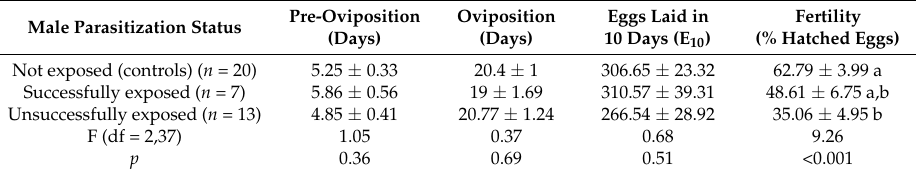
Table 3. Pre-oviposition and oviposition duration in days, total eggs laid in 10 days (E 10 ) and fertility (% hatched eggs) (means ± SE) of H. axyridis females paired with males not exposed to D. coccinellae (controls), exposed and successfully parasitized (successfully exposed) or exposed but not successfully parasitized (unsuccessfully exposed). Pre-Oviposition Oviposition Eggs Laid in Fertility Male Parasitization Status (Days) (Days) 10 Days (E 10 ) (% Hatched Eggs) Not exposed (controls) ( n = 20)